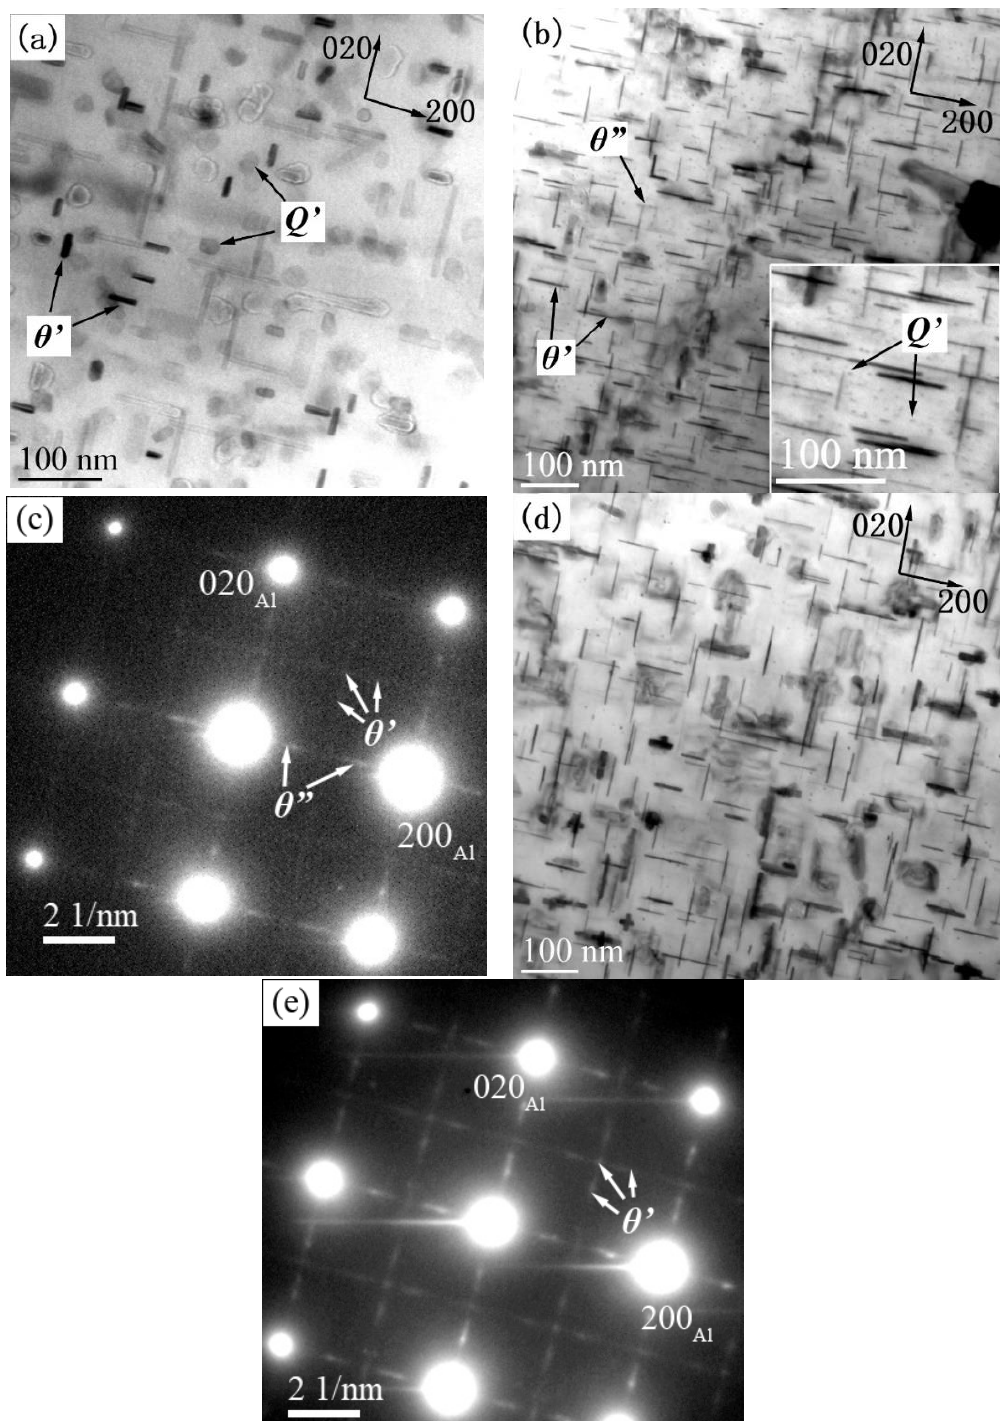
Figure 9. TEM bright-field images of the Al-Si-Cu-Mg 319 alloy after ( a ) T5, ( b ) T6, and ( d ) T7, and the corresponding SADPs for ( c ) T6 and ( e ) T7.